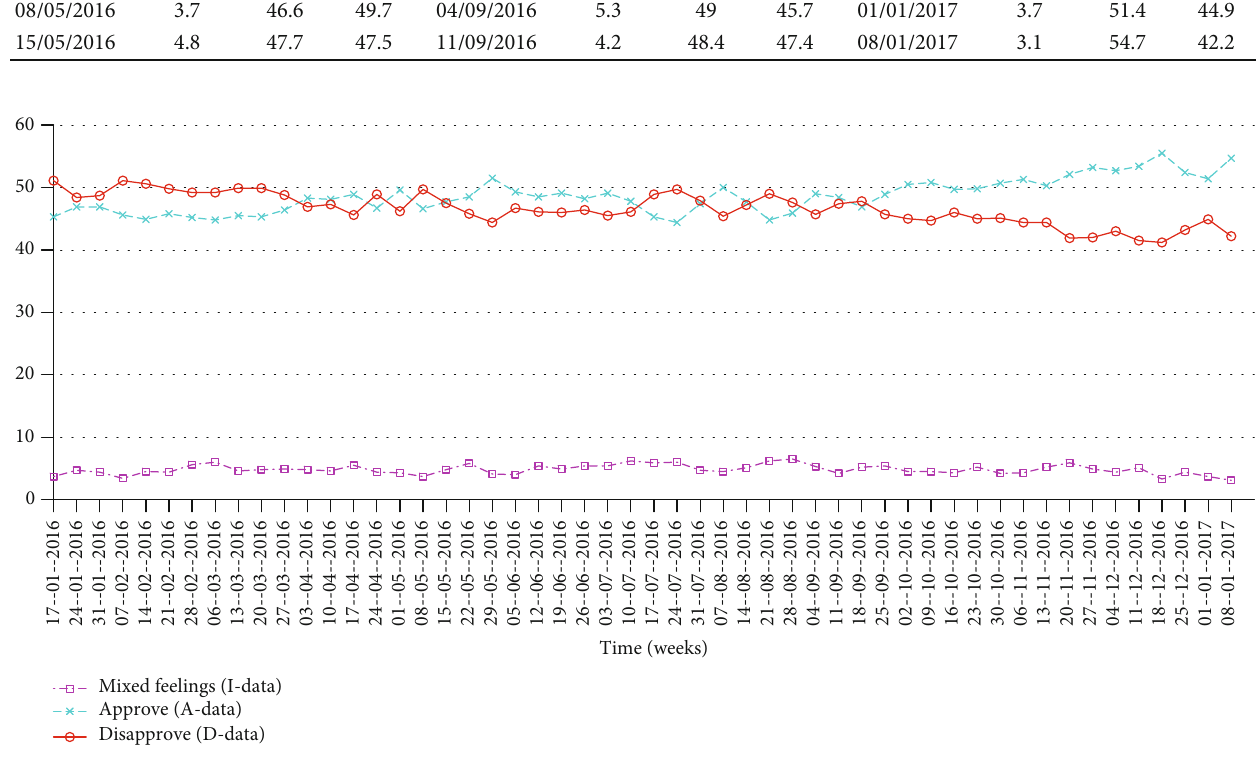
Figure 2: Data of the fi rst poll from [14], entitled: Overall, do you approve or disapprove about the way Obama is handling his job as President? see Table 2 for more details.